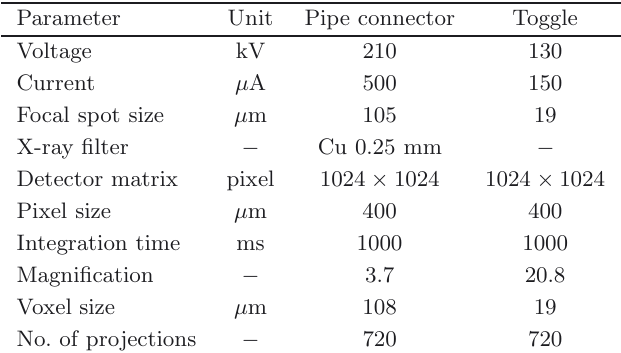
Table 2. An overview of the scanning